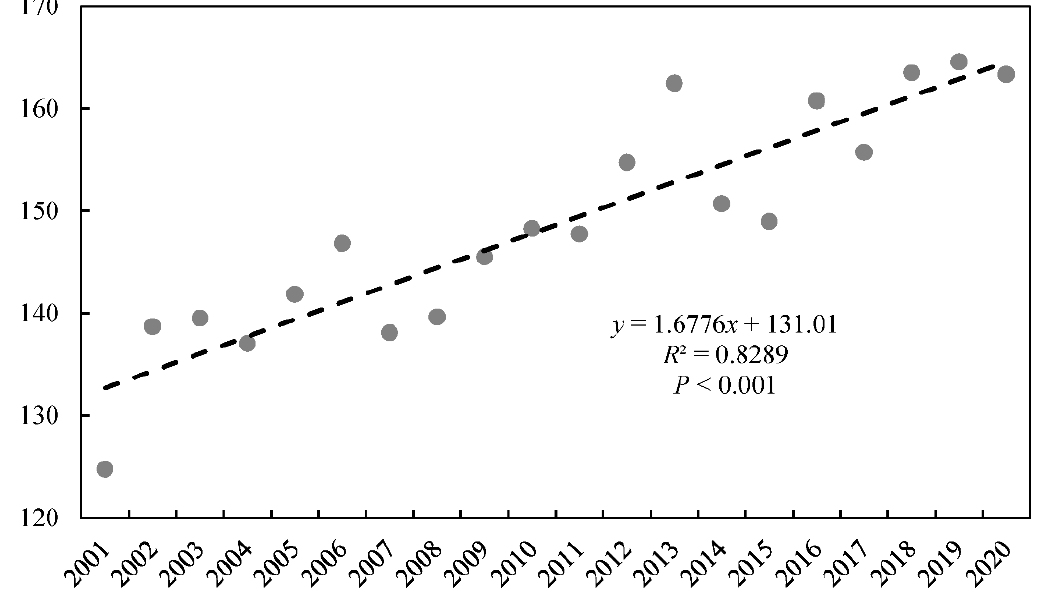
Figure 6. Changes in the annual mean ANPP (2001–2020).